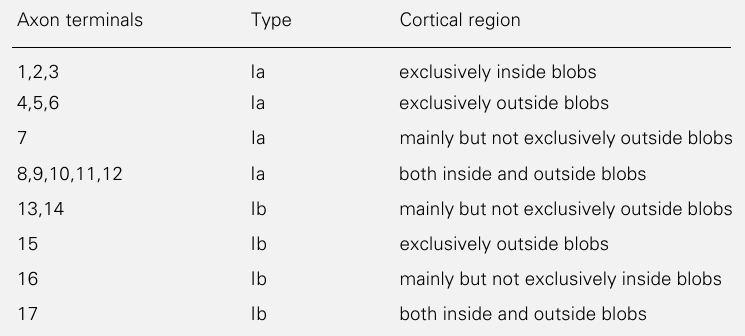
Table 4 - Segregation pattern of intrinsic axon terminals of V1 of Cebus apella. Axon